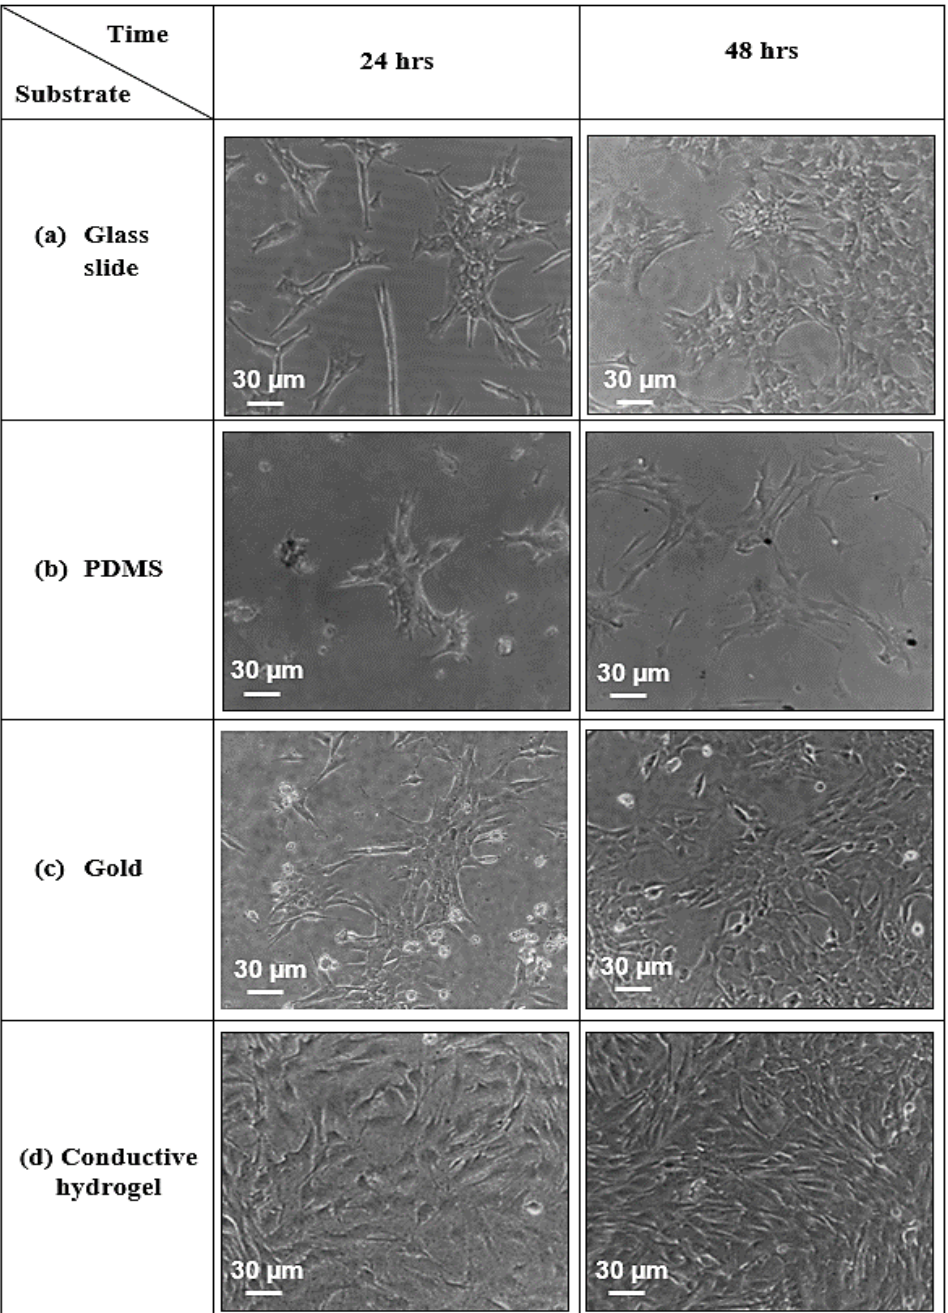
Figure 15. The growth of C2C12 cells for 24 and 48 h on different substrates. The image shows cells growing on ( a ) glass slide (control), ( b ) PDMS (control), ( c ) gold (control) and ( d ) 4% CH.